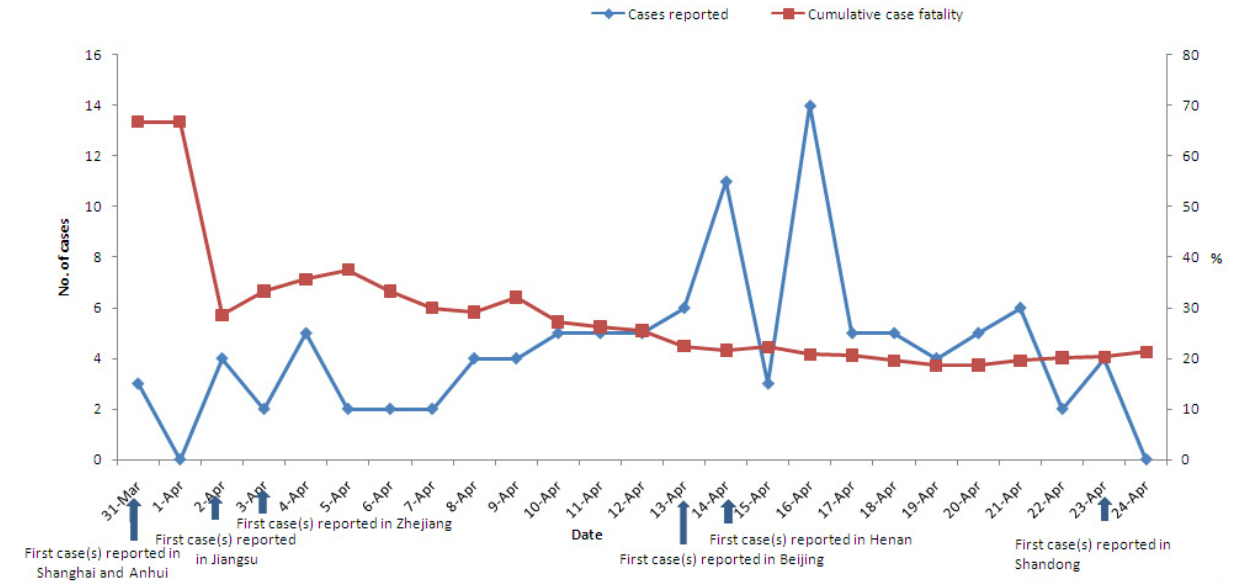
Figure 1. The human cases of avian influenza A H7N9 virus infection reported with the first case(s) by province/city and the cumulative fatality rate in China from March 31 to April 24,